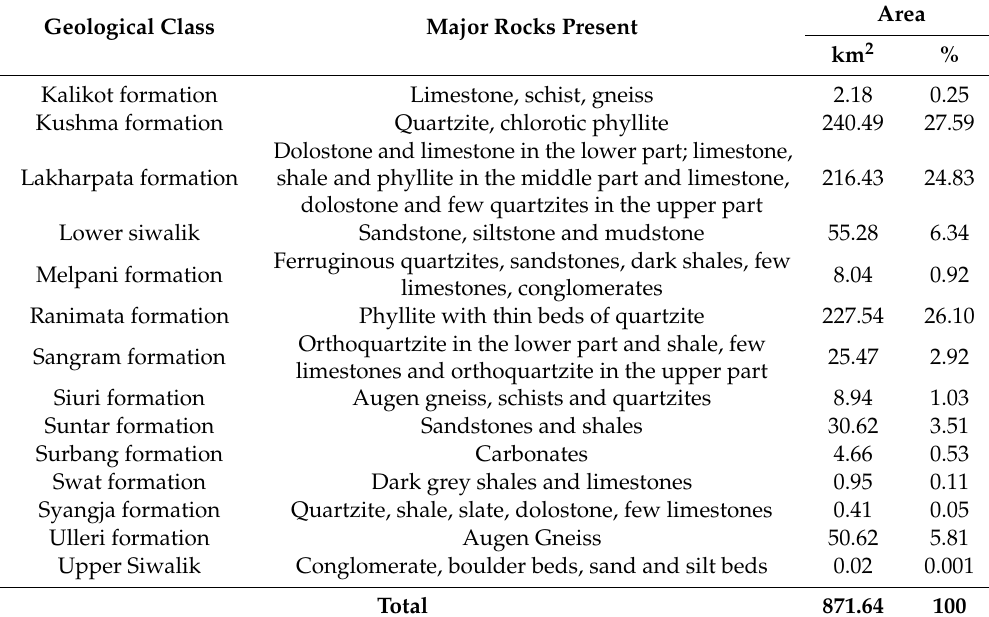
Table 4. Major geological units and their distribution in the study area.